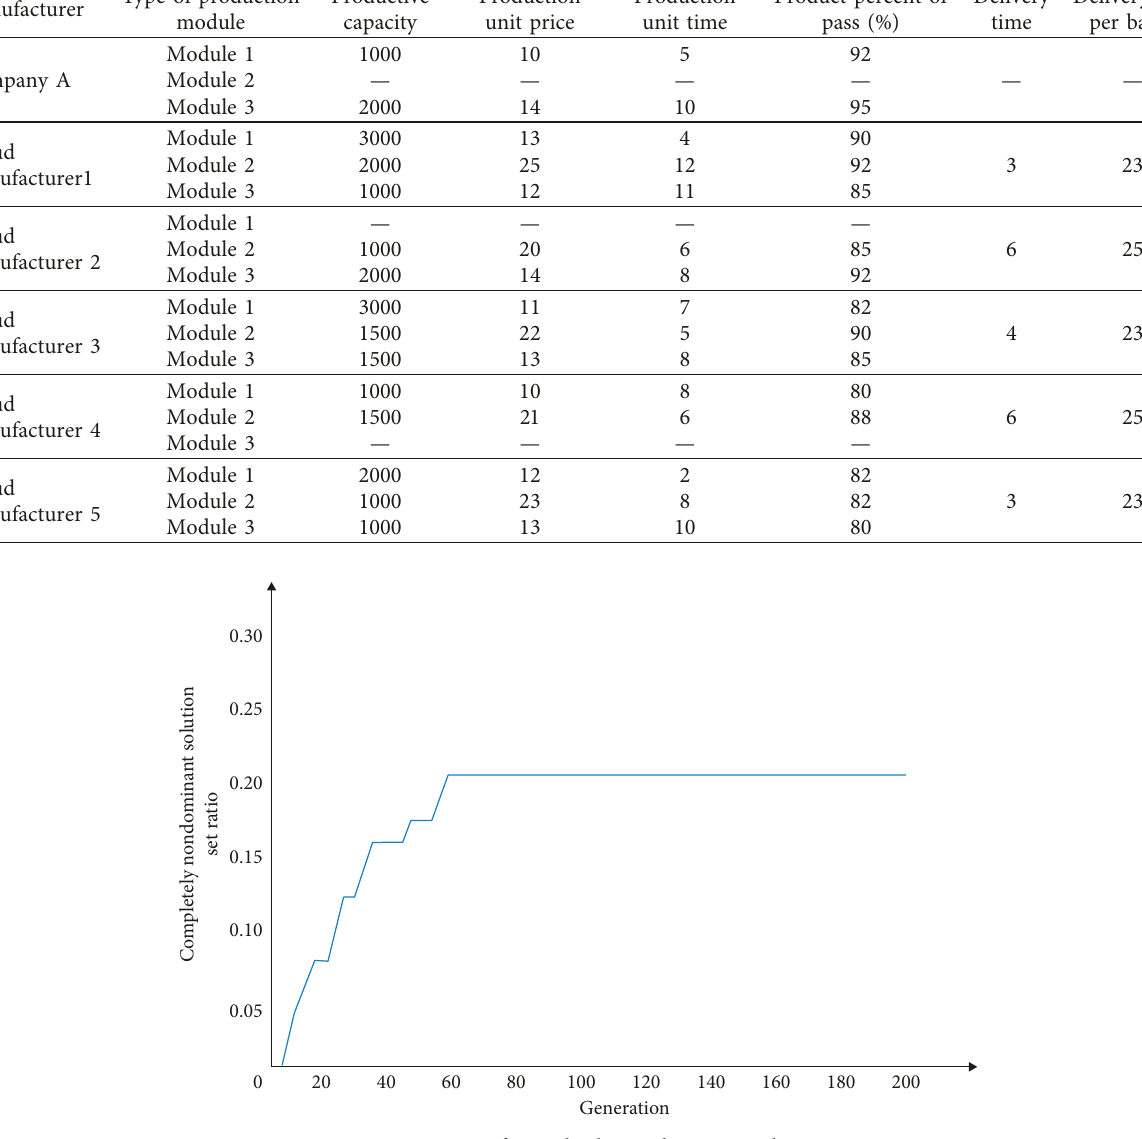
Figure 4: Proportion of completely nondominant solution